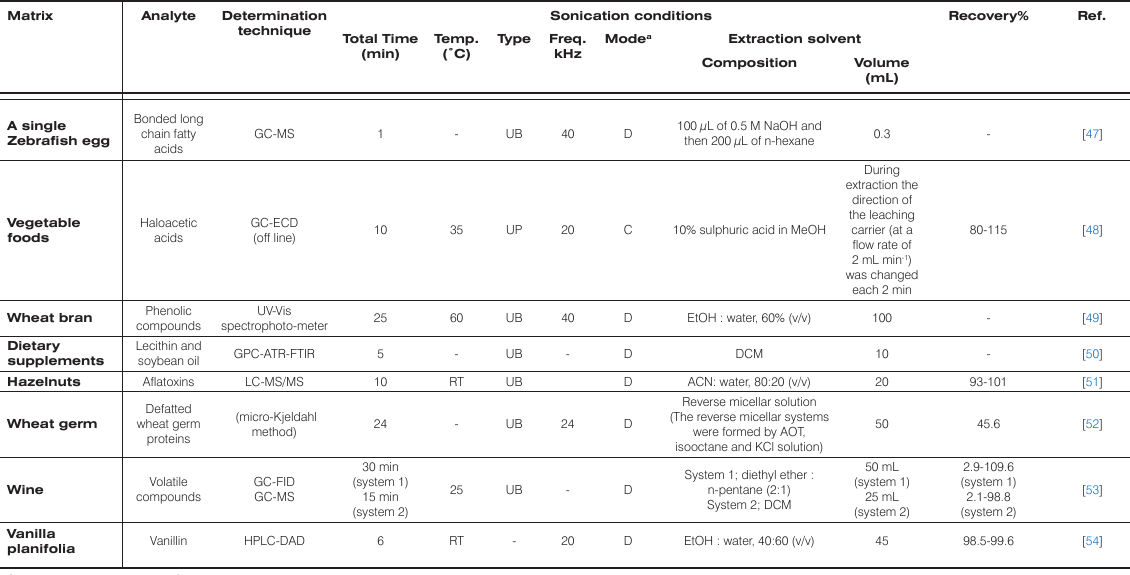
Reverse micellar solution (The reverse micellar systems were formed by